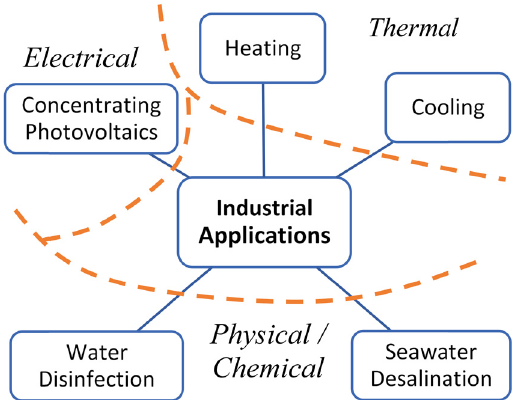
Figure 9: Classi fi cation of industrial applications.